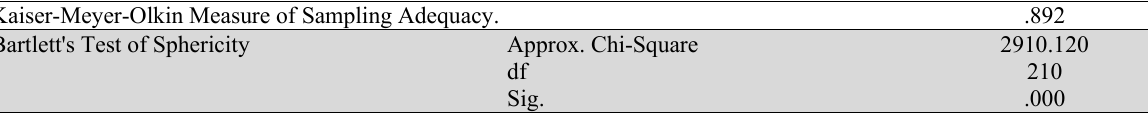
Result of KMO and Bartlett’s test Kaiser-Meyer-Olkin Measure of Sampling Adequacy. .892 Bartlett's Test of